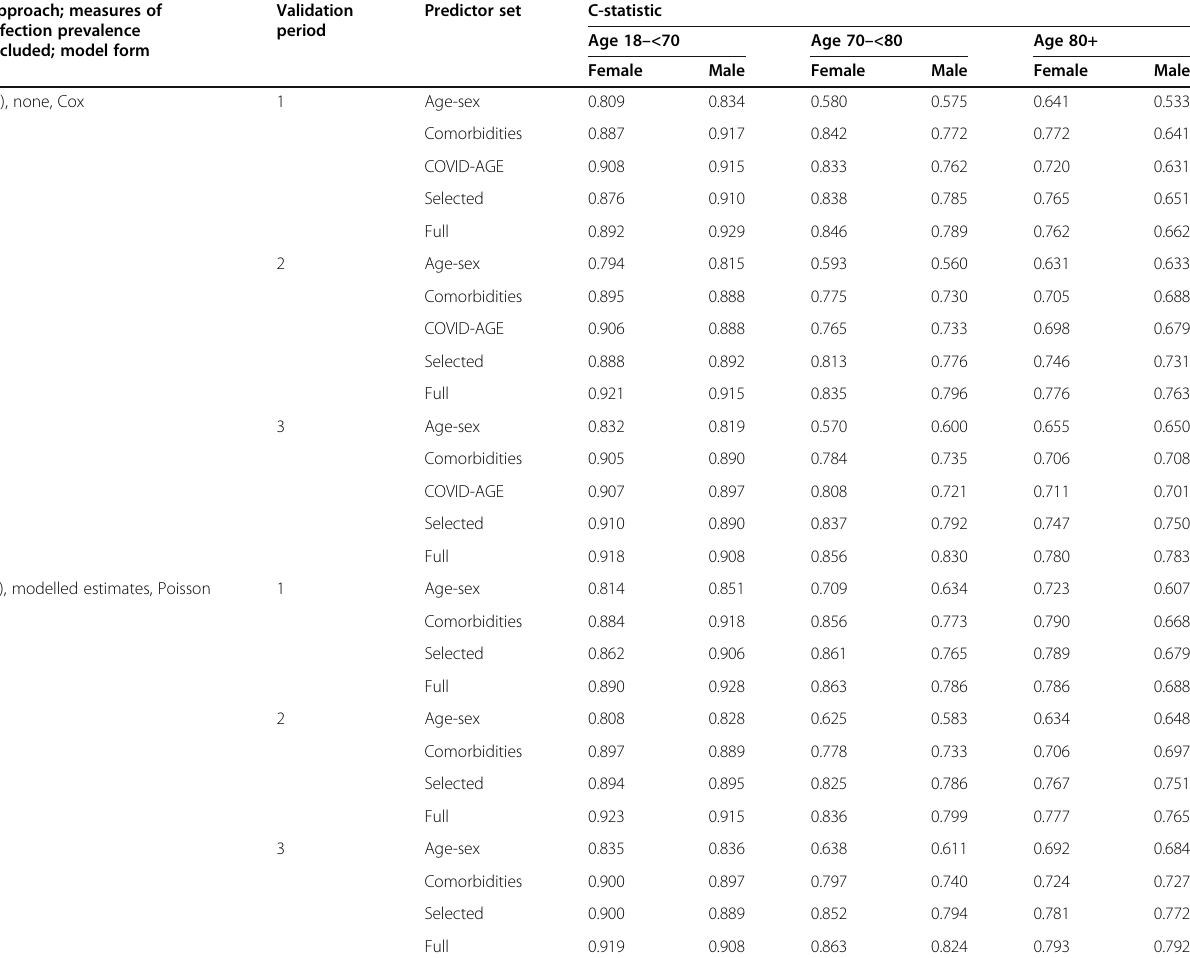
Table 3 C-statistics for different sets of predictor variable sets, by sex and broad age group Approach; measures of infection prevalence included; model